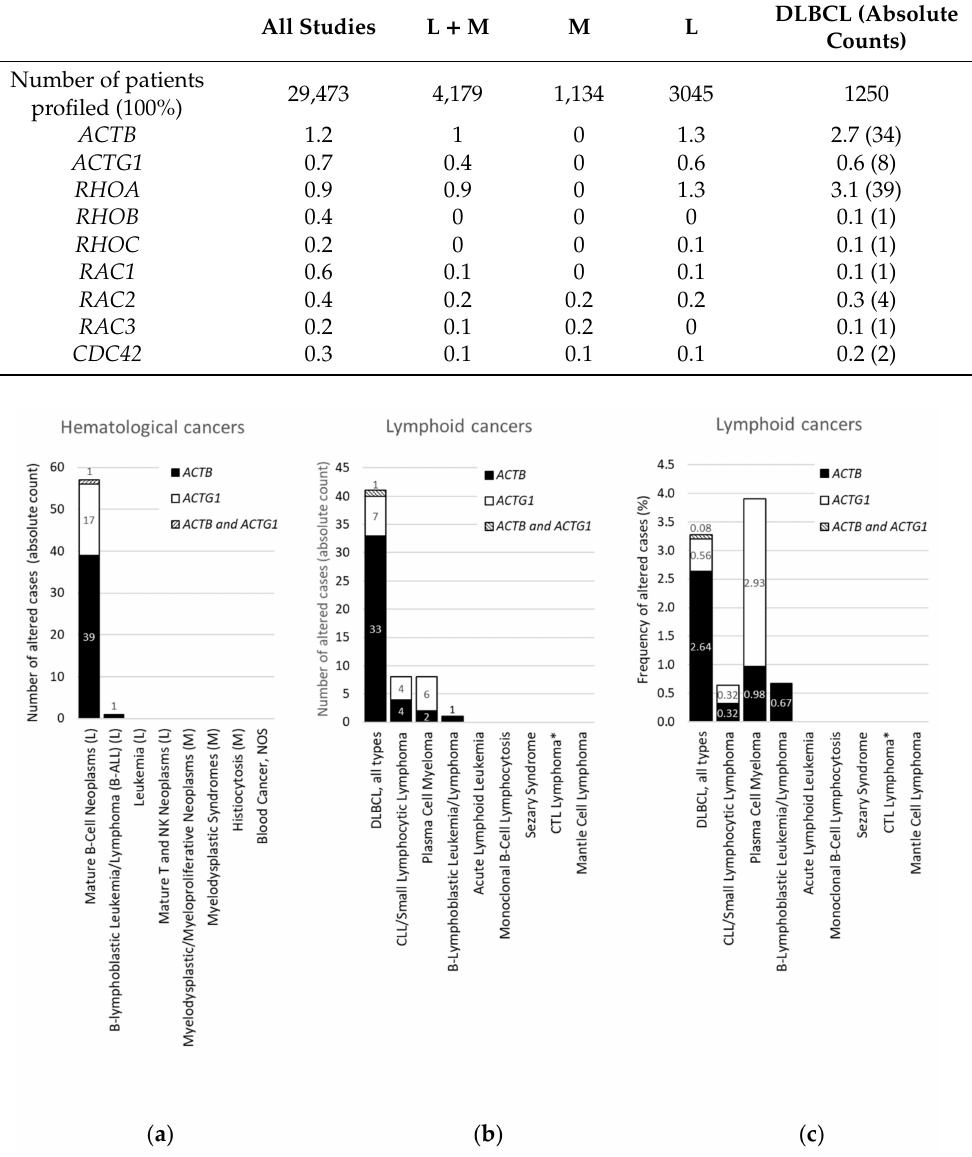
Table 3. Frequency (altered / profiled patients, in %) of somatic mutations of the indicated genes in the selected 174 studies (all studies) (Table S1), the lymphoid (L) and myeloid (M) studies (Table S2), and DLBCL cases. Data derived from the OncoPrint tabs except for these in column ‘DLBCL’ which were derived as in Figure 3c.